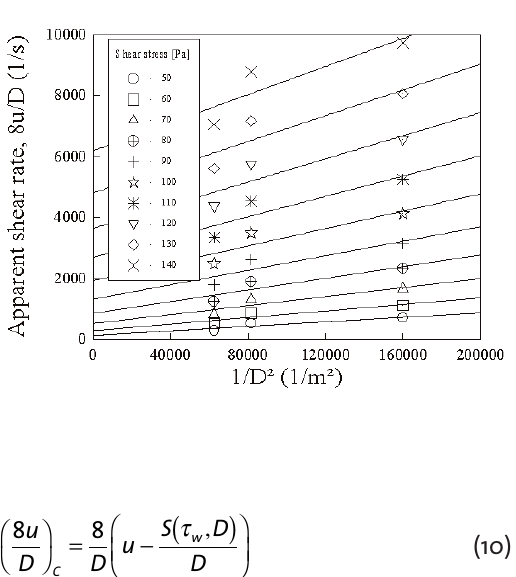
Figure 8 (left): Application of the Oldroyd- Jastrzebski method for a 0.3%PEO foam (shear rate as function of 1/D 2 at given shear stress). A straight line was fit to the experimental data points for each wall stress using the least squares method. Figure 10 (right): Slip velocities as a function of wall shear stress for a 0.3% PEO foam.